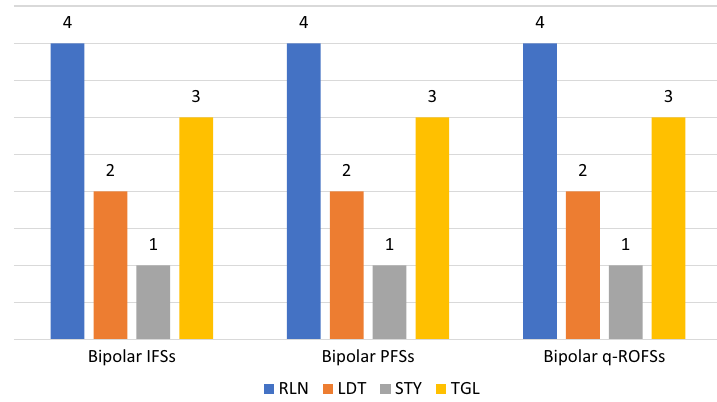
Fig. 4 Graphical representations of the weighting priorities